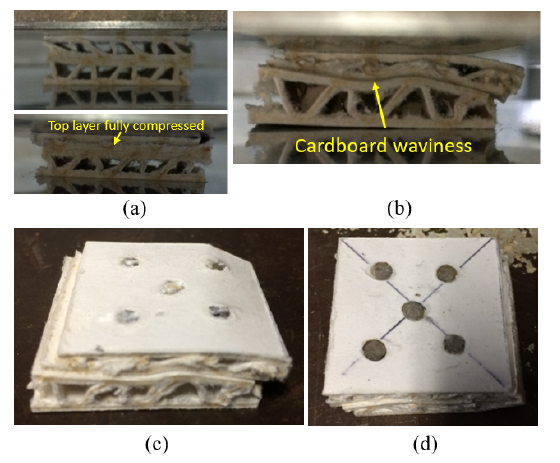
Figure 4: (a) Two-layer cardboard structure during compression test- ing; (b) two-layer cardboard panel with rods during compression testing; (c) top surface of two-layer cardboard panel with rods af- ter compression testing; (d) bottom surface of two-layer cardboard panel with rods after compression testing.